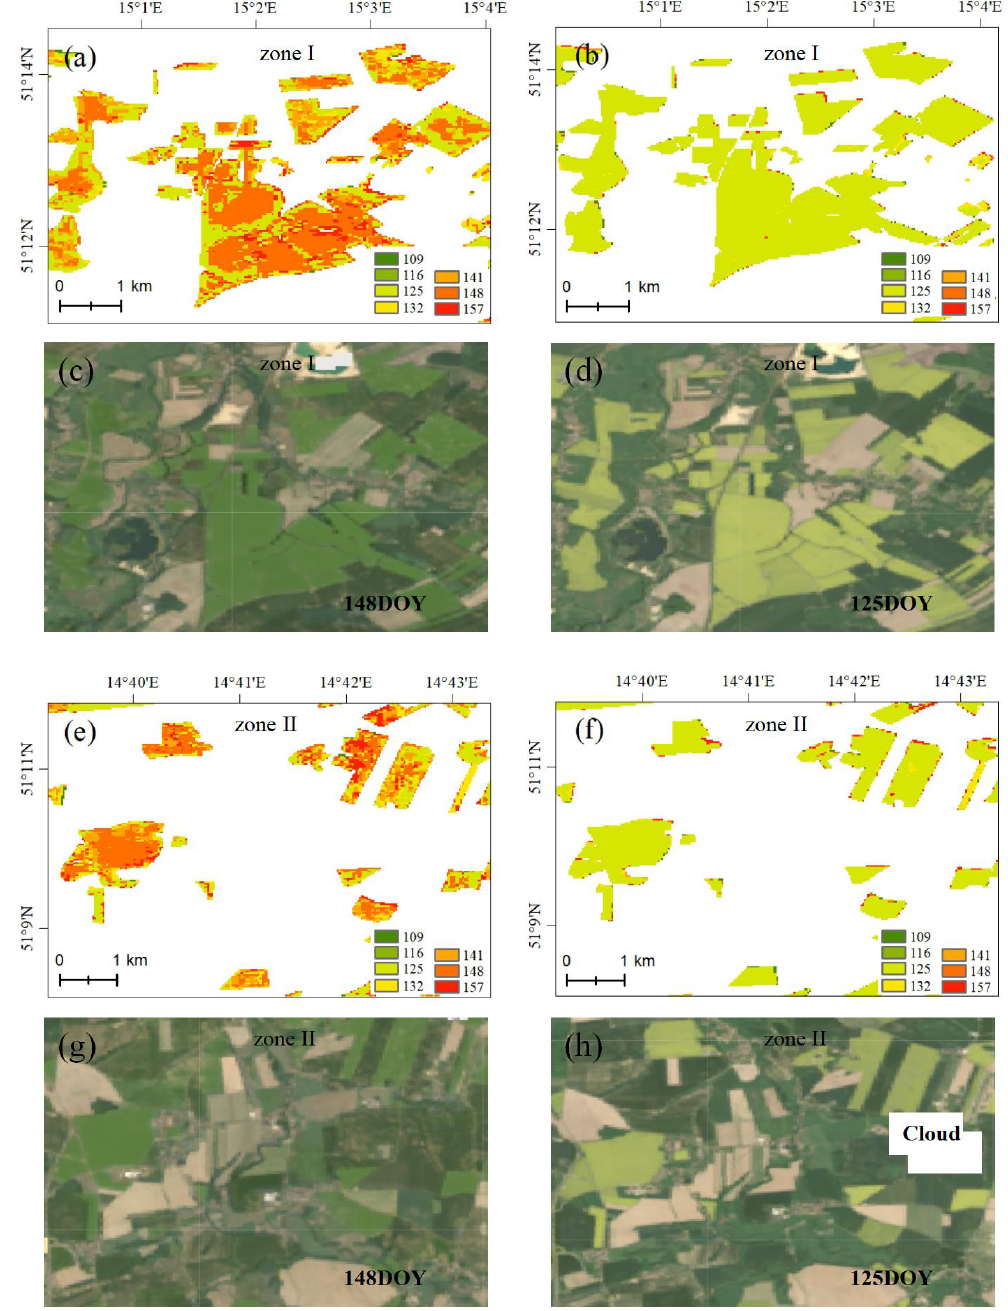
Figure A2. Zoomed-in images and rapeseed flowering peak (Day of Year, DOY) maps in 2018. The base maps are RGB- composite images using the red, green, and blue bands of the Landsat 8. The zoomed-in regions are Zone Ⅰ and Zone II in Figure A1. Flowering peak as obtained by NDYI ( a ), ( e ) and NRFIr ( b ), ( f ). ( c ), ( d ), ( g ), and ( h ) are true color images of different dates and locations.